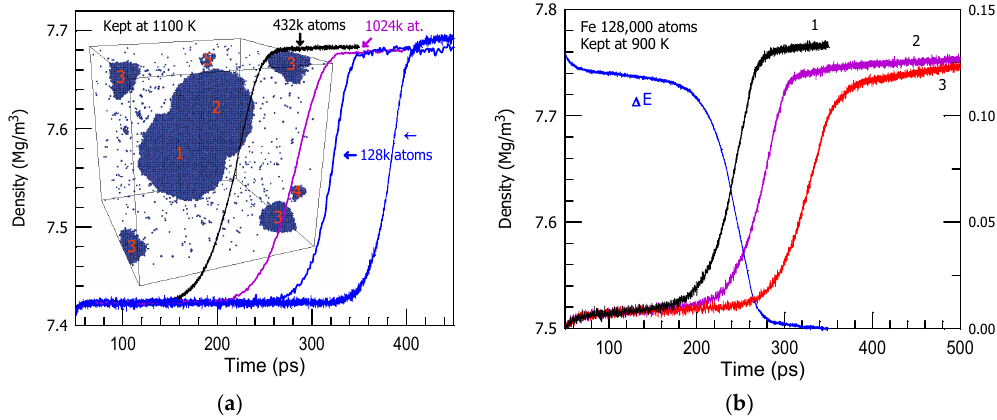
Figure 3. Density change as a function of time for pure Fe at 1100 K (different atomic cell size used as indicated) ( a ) and 900 K ( b ) (three simulations, same cell size of 128,000 atoms). Inset in ( a ) shows an atomic cell of 1.024 million atoms at 250 ps containing 5 growing nuclei as marked. ( b ) also shows the total energy difference ( Δ E ) for graph 1 for comparison. Initial 50 ps are related to heating and cooling time.